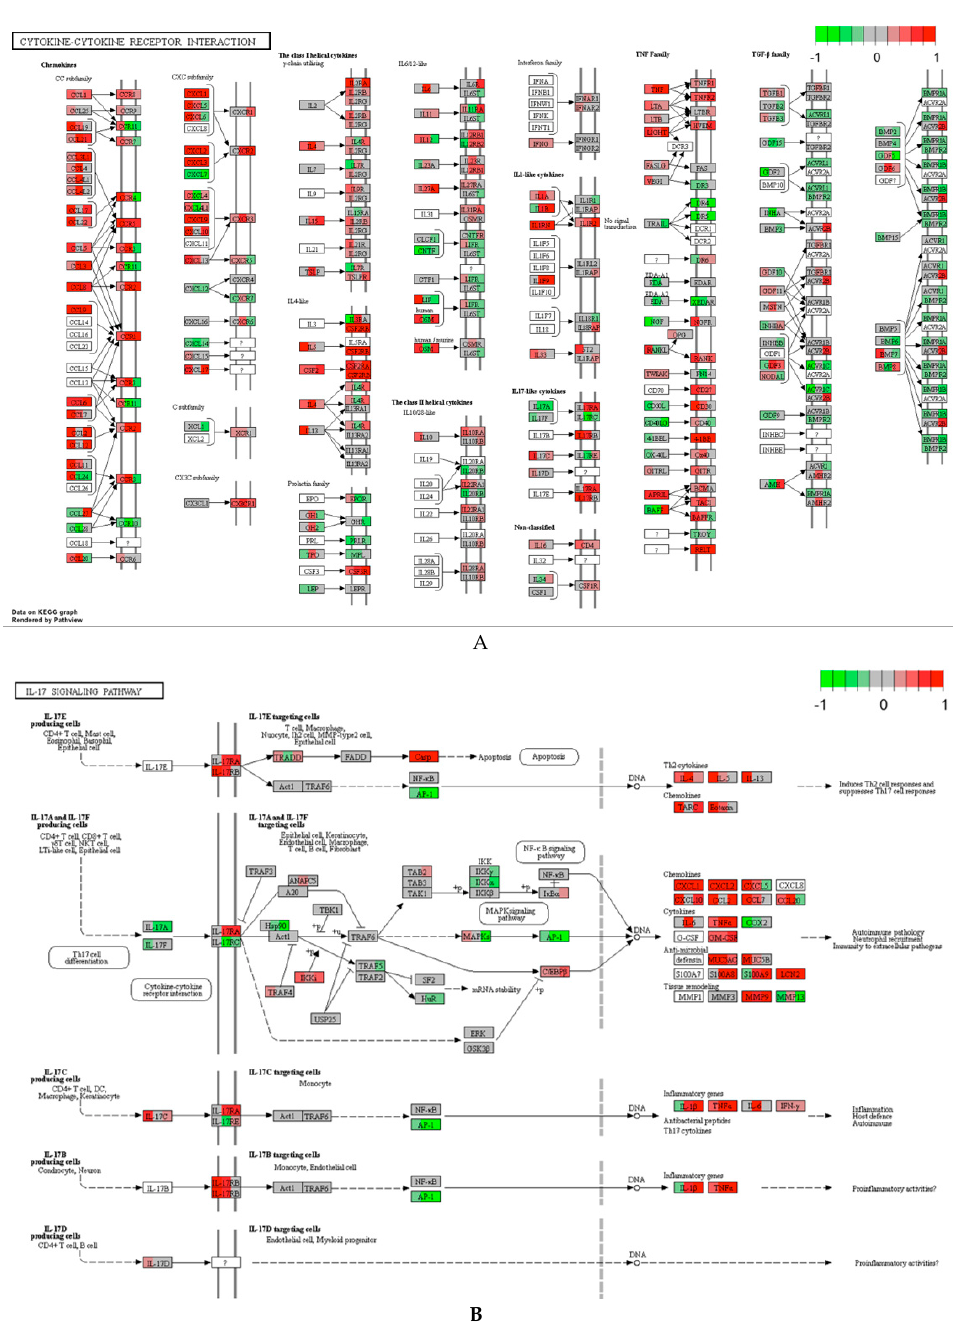
Figure 3. Example KEGG pathways upregulated by 1/10 SAF oil in male mice. (A) Cytokine-cytokine receptor interaction pathway; (B) IL-17 signaling pathway. receptor interaction pathway; ( B ) IL-17 signaling